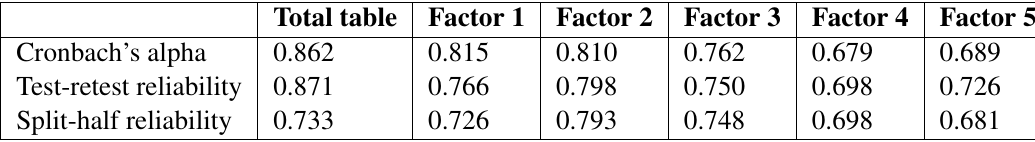
Table 6 Reliability analysis table of the Chinese version of